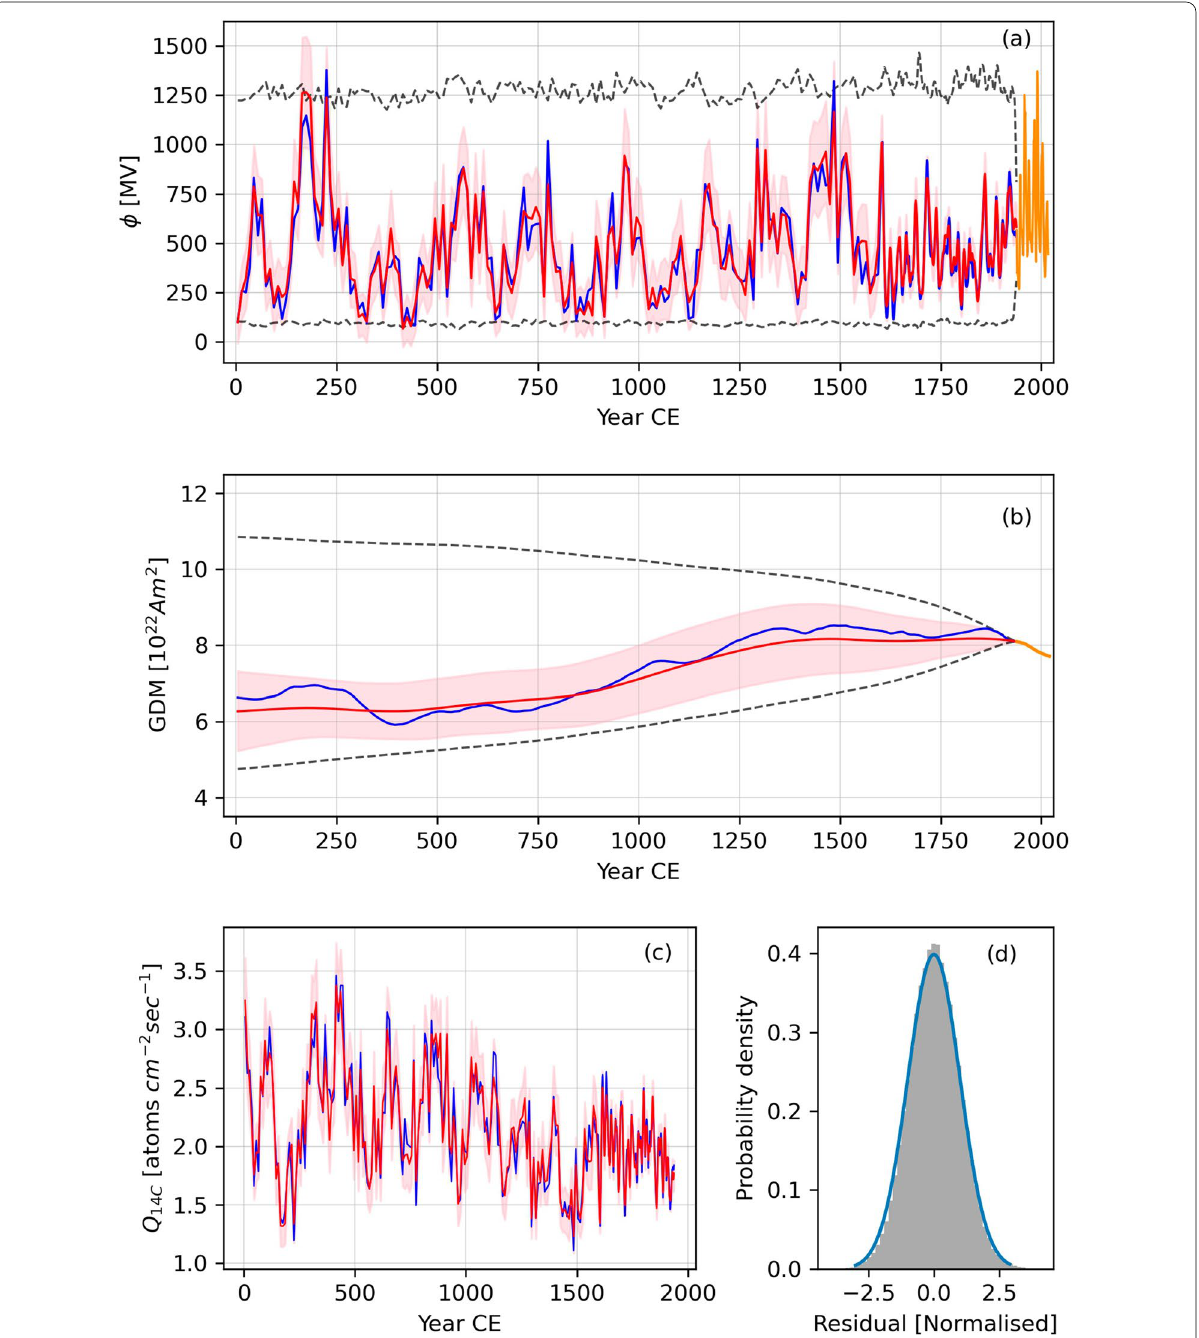
Fig. 8 Assessing solar activity and GDM reconstruction of the Bayesian model with the synthetic dataset. Posterior distributions of solar activity ( a ) and GDM ( b ) depicted with means (red lines) and 2-sigma uncertainty of a thousand realizations (light red shadings). The prior distributions are also depicted with the 2-sigma uncertainty (black dashed lines). The blue lines represent the reference φ’ and M’ and the orange lines represent the recent values that the model is connected to, i.e., φ HE16 and GDM based on COV-OBS. 2. c Shows the mean (red line) and 2-sigma uncertainty × (light red shading) of a thousand 14 C production rate curves generated by the recovered φ and M . The reference 14 C production rate is represented by the blue line. d Shows the histogram of the model-data residuals (grey bars) defined as the differences between individual posterior realizations of 14 C production rate and the input 14 C data, normalized by the data uncertainties. A standard normal distribution is shown as the blue line for